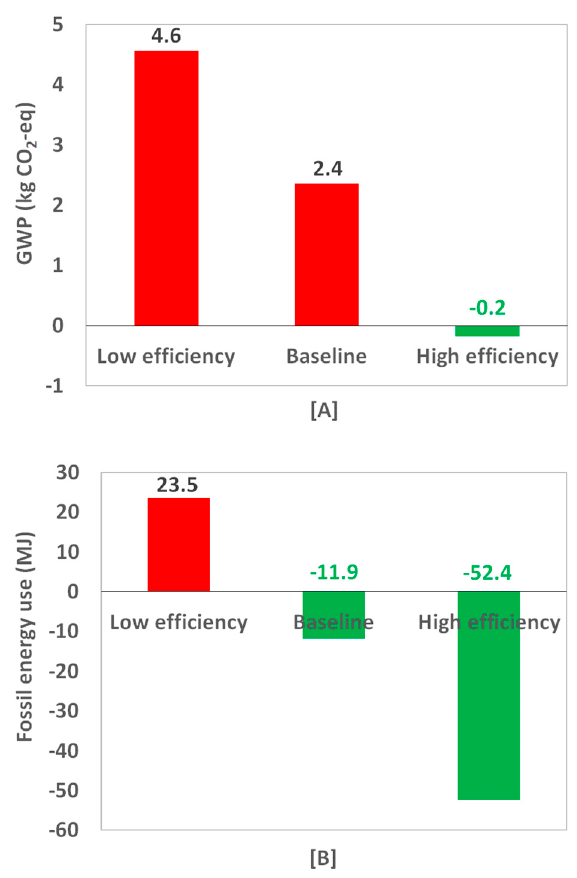
Figure 4. Impacts of gasification-boiler performance on ( A ) global warming potential (GWP 100a), and ( B ) fossil fuel energy use (MJ).